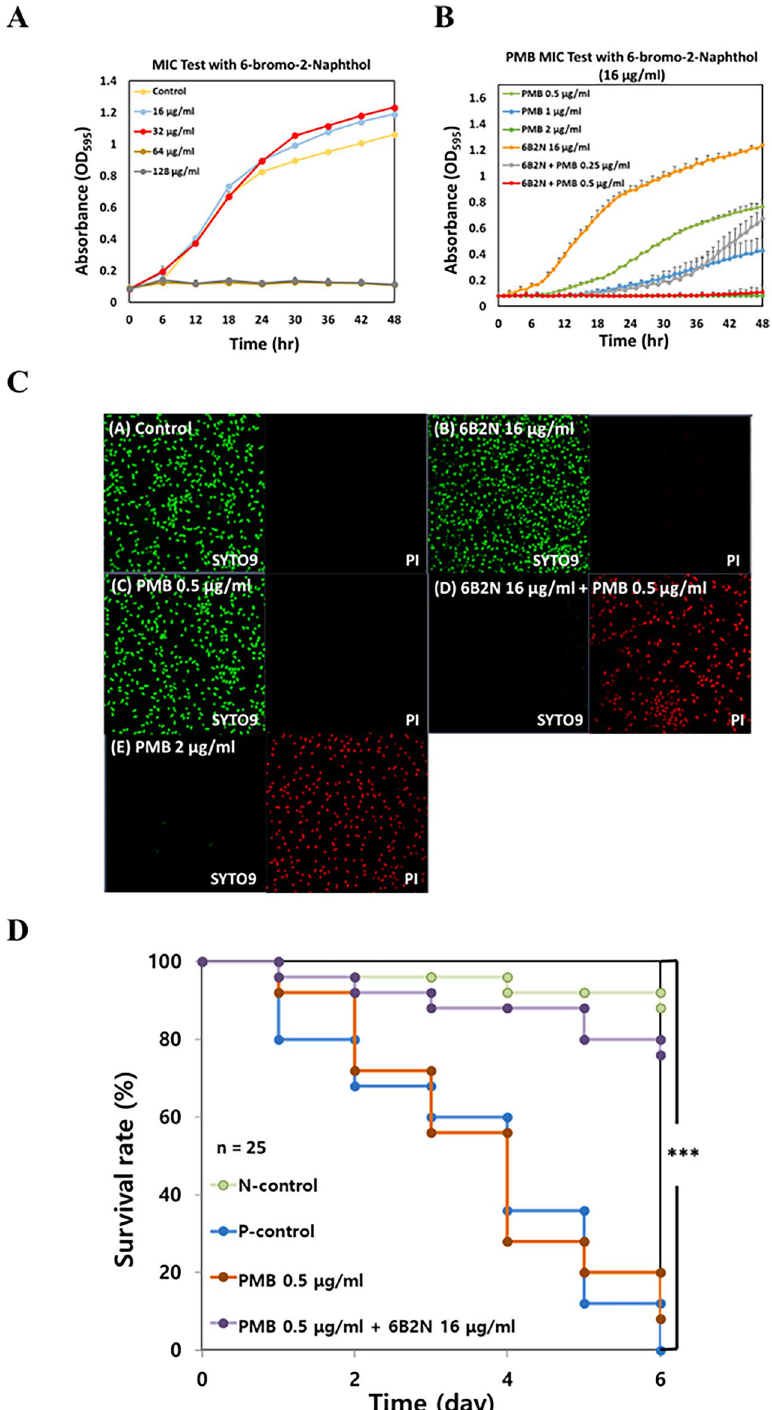
Figure 4. Bactericidal effect of 6-bromo-2-naphthol on A. baumannii . ( A ) Growth test of A. baumannii treated with only 6-bromo-2-naphthol. The concentration of 6-bromo-2-naphthol was set at 1–256 μg/mL. ( B ) Assessment of the synergistic effect of PMB and 6-bromo-2-naphthol. The concentration of 6-bromo-2- naphthol used in the experiment was fixed at 16 μg/mL. The same volume of ethanol was used as the positive control. ( C ) Visualization of synergistic effects using SYTO9™ and PI dye based on CLSM images. ( D ) In vivo synergistic effect using G. mellonella . G. mellonella larvae were divided into two groups: (1) PMB alone and (2) PMB and 6B2N. A total of 25 larvae of Galleria mellonella per condition were infected with the A. baumannii ATCC 17978 cells in the presence and absence of our tested compounds . The survival rate of each group was assessed for 5 days. Statistical analysis was performed using Student’s t -test (* P < 0.05, *** P <